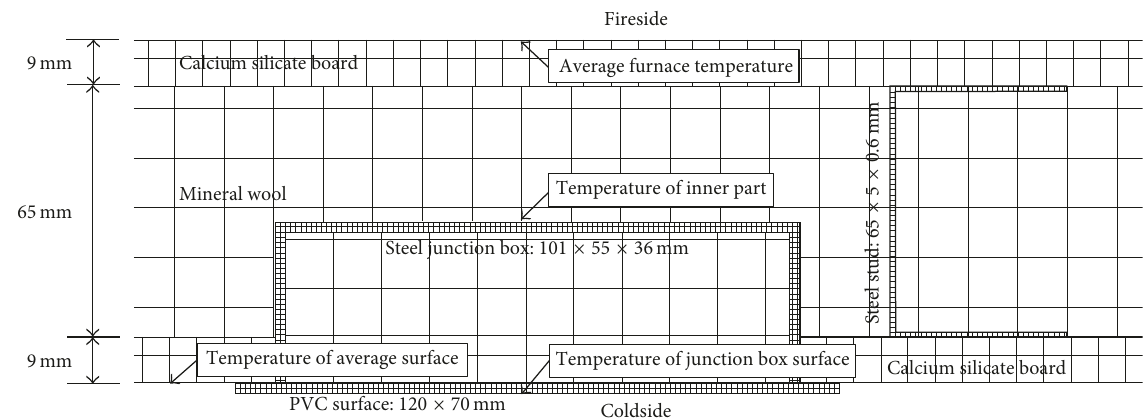
Figure 4: Cross section of the wall with indication of numerical modelling and the thermocouple position in Test